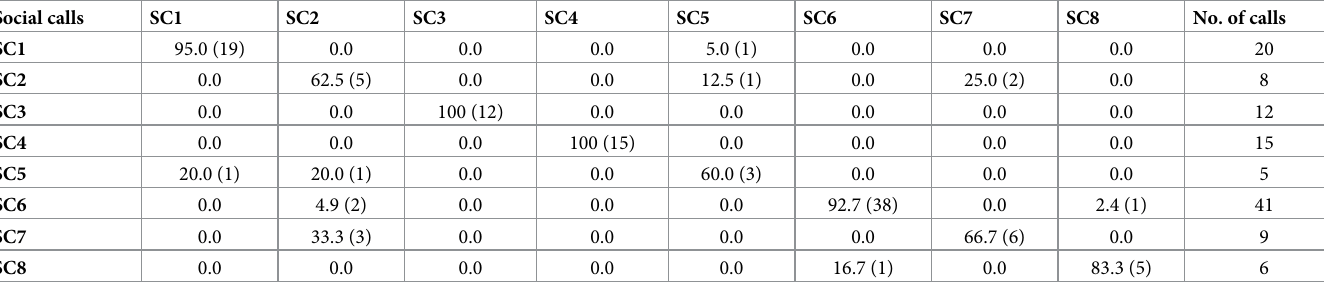
Table 2. Classification success [%] of the cross-validated discriminant function analysis for eight social call types.